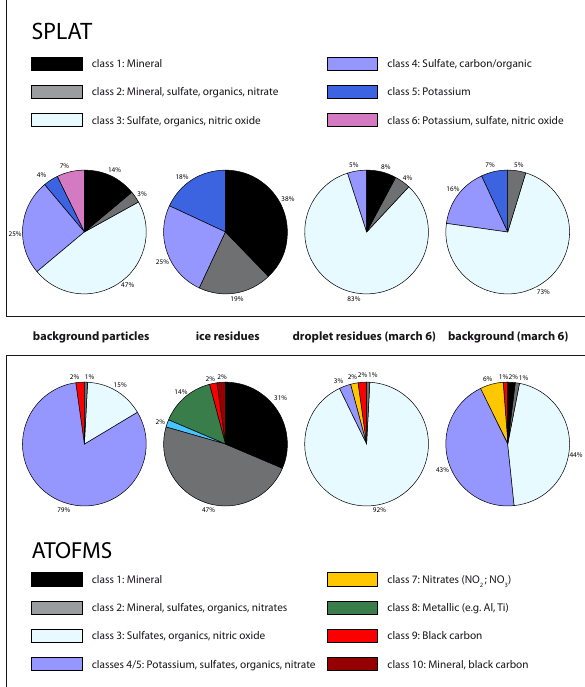
Fig. 4. Frequency of occurrence of particle classes for SPLAT (up- per row) background particles (9764), ice residues (355), droplet residues (6 March, 162), background particles (6 March). ATOFMS (lower row) background particles (3212), ice residues (152), droplet residues (6 March, 1094), background particles (6